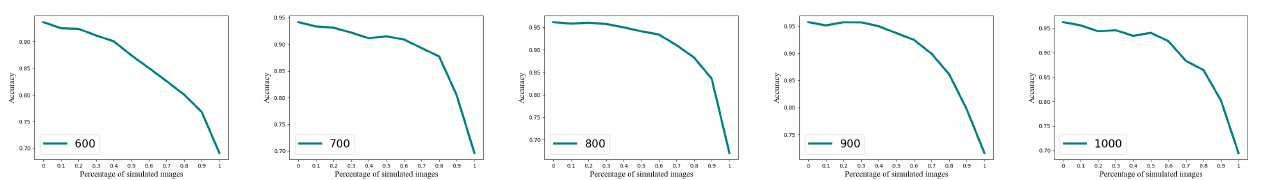
Figure 22. A series of HRR curves with different amount of training data.